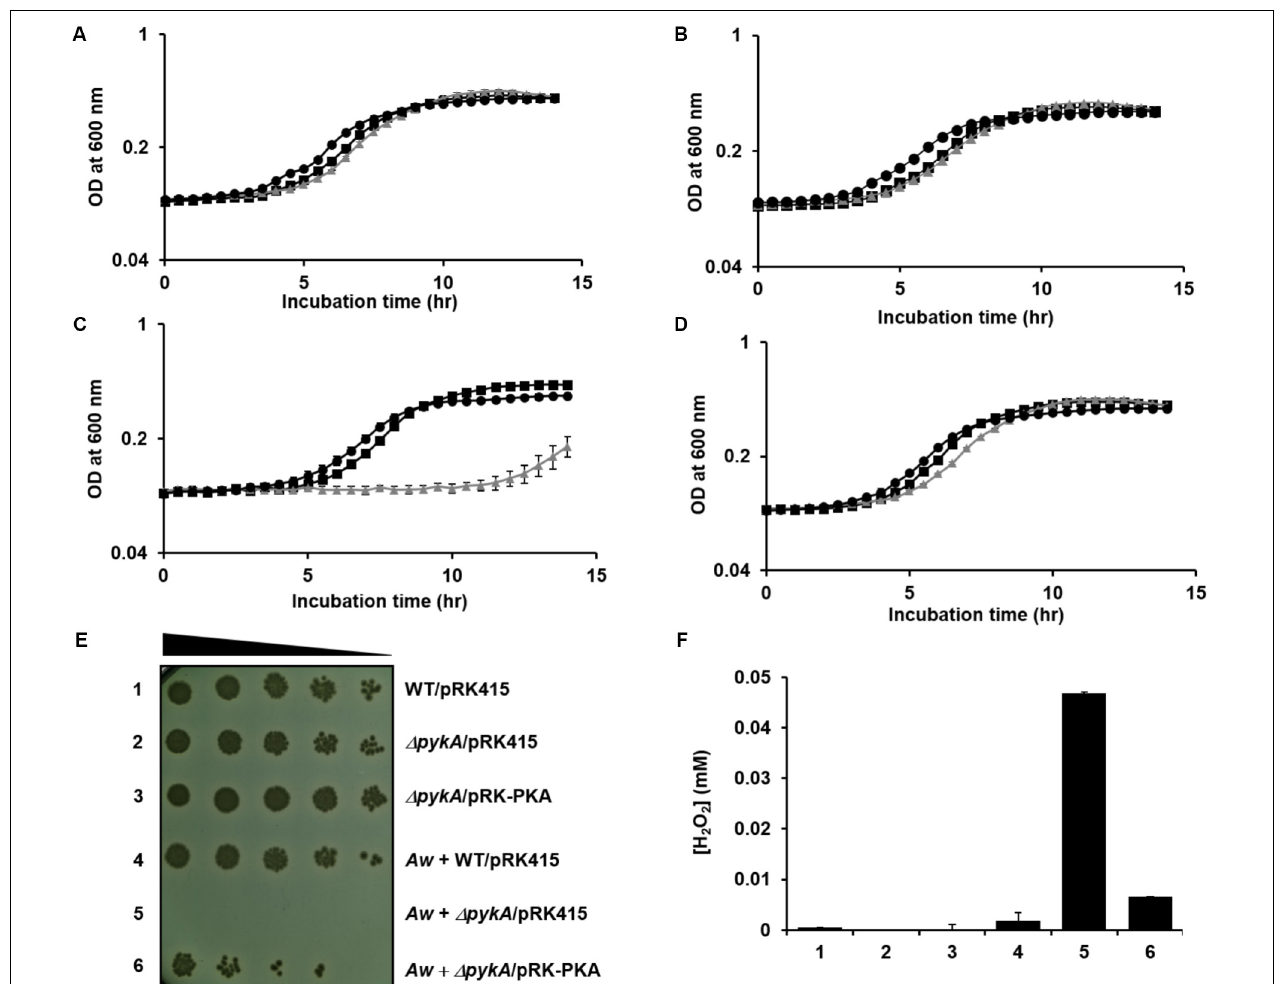
FIGURE 5 | Effect of PykA activity on the survival of V. vulnificus against H 2 O 2 stress generated by its fungal neighbors in the presence of glucose. (A–D) Wild-type V. vulnificus CMCP6 (squares), the pykA mutant (triangles) and the complemented strain (circles) were inoculated in (A) fresh M9S medium containing 0.2% glucose, (B) the cell-free culture filtrate of A. fumigatus grown in M9S medium containing 0.2% glucose, (C) the cell-free culture filtrate of A. welwitschiae grown in M9S medium containing 0.2% glucose, or (D) the cell-free culture filtrate of A. welwitschiae grown in M9S medium containing 0.2% glucose and 1 mM sodium pyruvate. Bacterial growths were then monitored by measuring the optical density at 600 nm and presented as the mean ± standard deviations ( n = 3). (E) The indicated strains of V. vulnificus were cultured alone (1–3) or with A. welwitschiae ( Aw , 4–6) in M9S medium containing 0.2% glucose. The overnight cultures were serially diluted fourfold and 1.5- µ l aliquots were spotted onto TCBS (thiosulfate-citrate-bile salts-sucrose) medium containing 2 µ g/ml tetracycline. (F) The H 2 O 2 levels in culture media from (E) were determined using the hydrogen peroxide assay kit (BioVision). The results are presented as the mean ± standard deviations ( n =